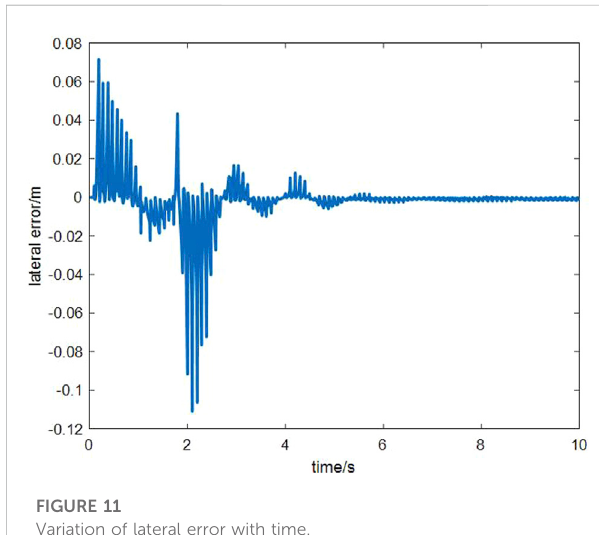
FIGURE 11 Variation of lateral error with time.